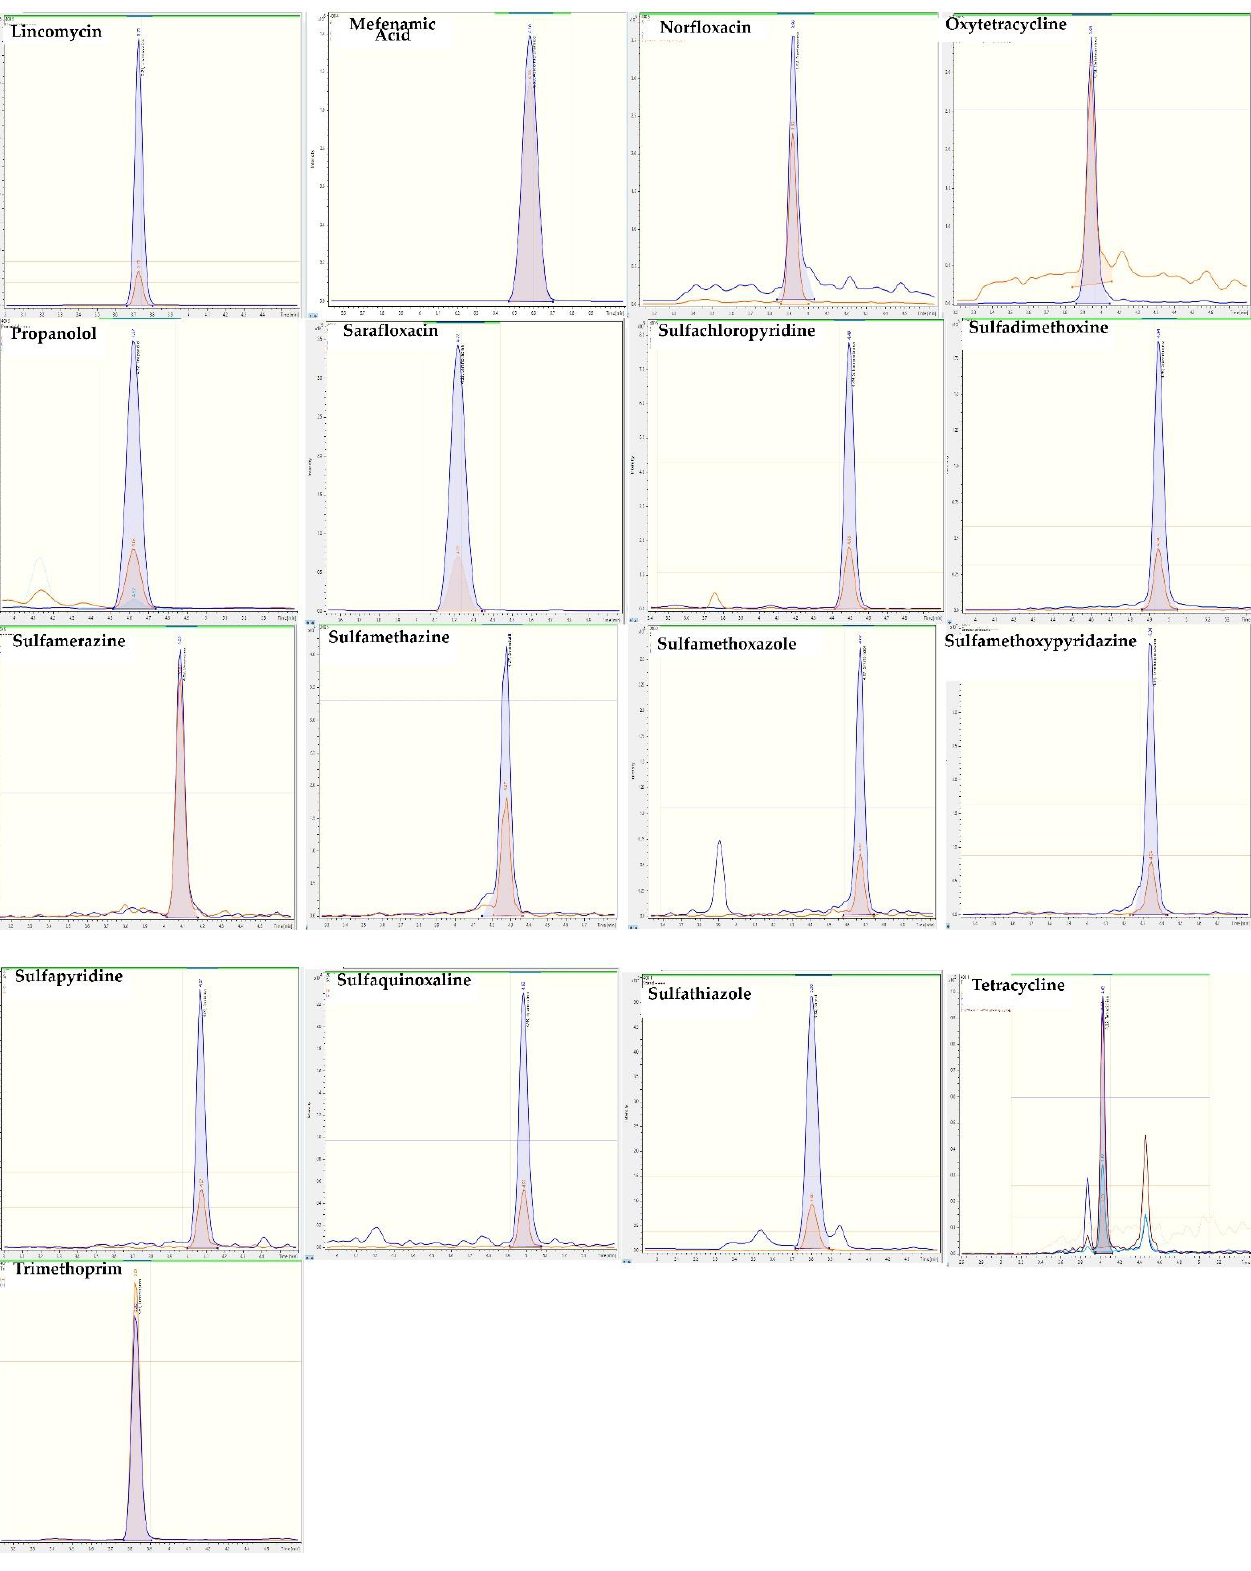
Figure 2. MRM chromatograms of pig feces sample fortified 29 veterinary drugs at the concentration level 400 μg/kg.